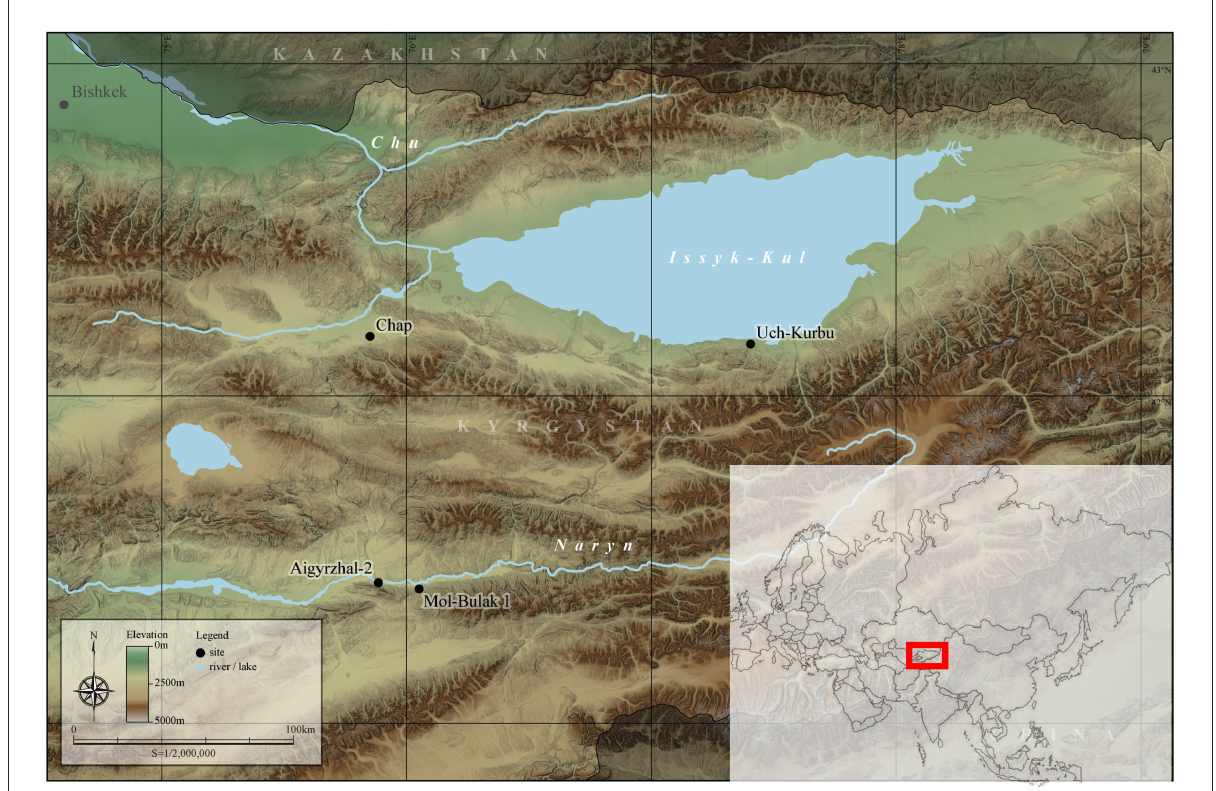
FIGURE1 Map of Kyrgyzstan showing Chap and other sites mentioned in the text. The red rectangle marks the position of the Kyrgyzstan on the Eurasian map. SRTM (NASA) for DEM, Digital Chart of the World (DCW) for water surface, Global Administrative Areas (GADM) for